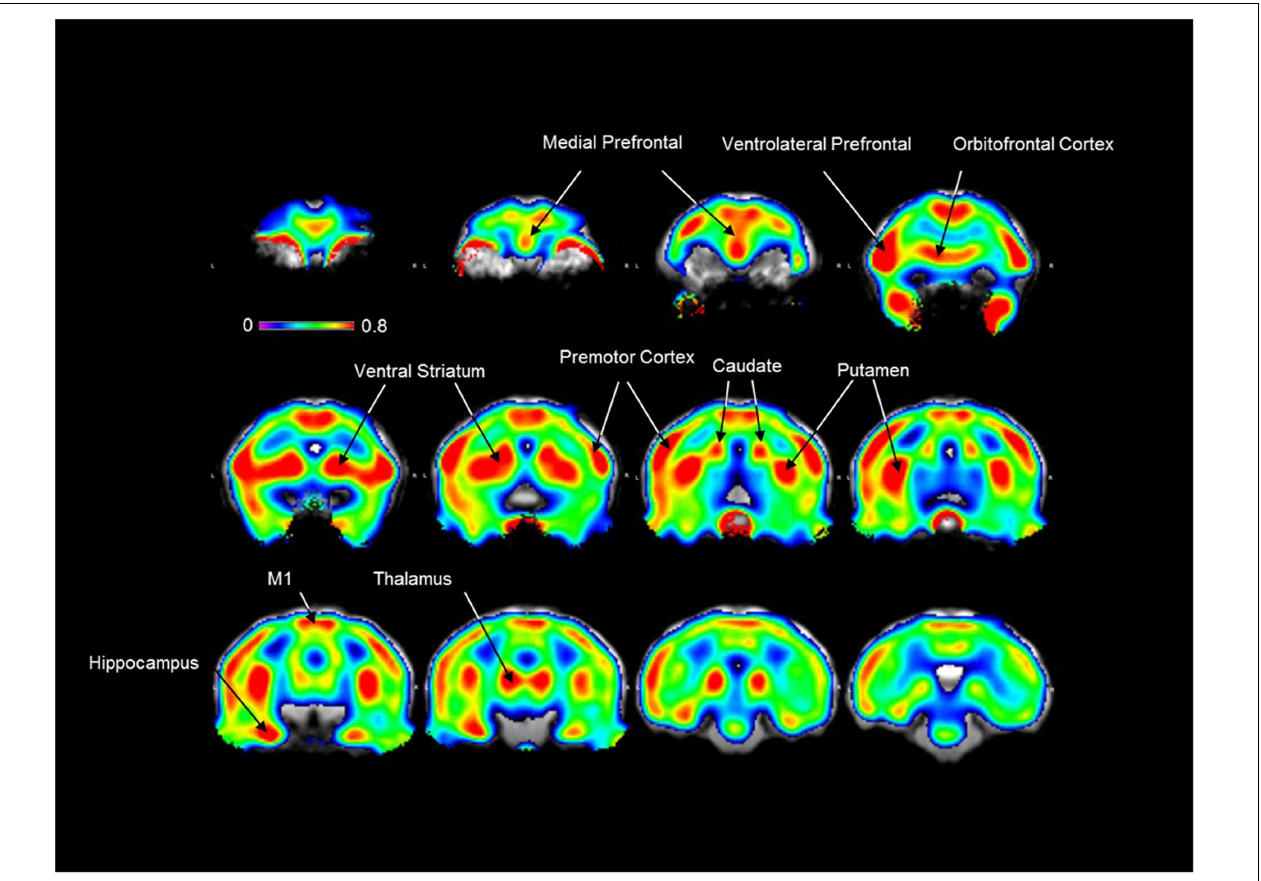
FIGURE 2 | [ 18 F]2FNQ1P BP ND in vivo distribution in macaque brain. Spatially normalized parametric images of [ 18 F]2FNQ1P BP ND were averaged over five monkeys. The resulting mean image was superimposed on the Macaca fascicularis brain MRI template. Twelve coronal slices along the antero-caudal axis are shown. Colors represent the level of non-displaceable binding potential using the cerebellum as reference region, with the medial and ventrolateral prefrontal cortex, orbitofrontal cortex, premotor and motor cortices, ventral striatum, caudate nucleus, putamen, hippocampus and thalamus showing the highest binding values. Outside the brain, [ 18 F]2FNQ1P binding is observed in the eyes and salivary glands but not in the